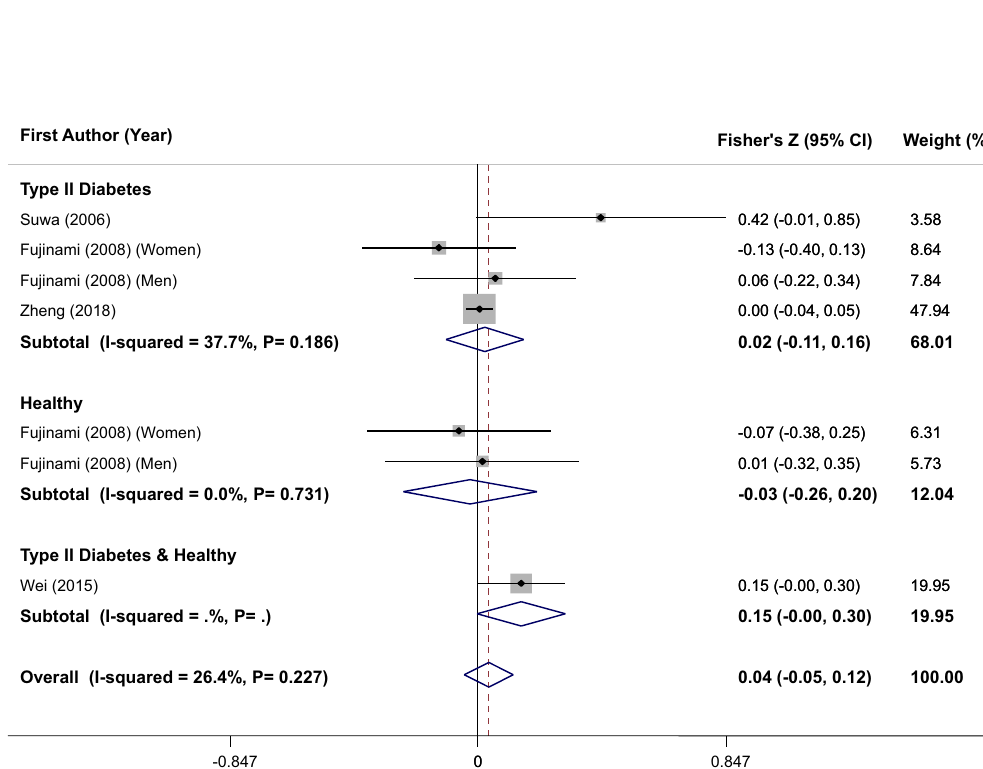
Subtotal (I-squared = .%, P= .) Overall (I-squared = 26.4%, P= 0.227)